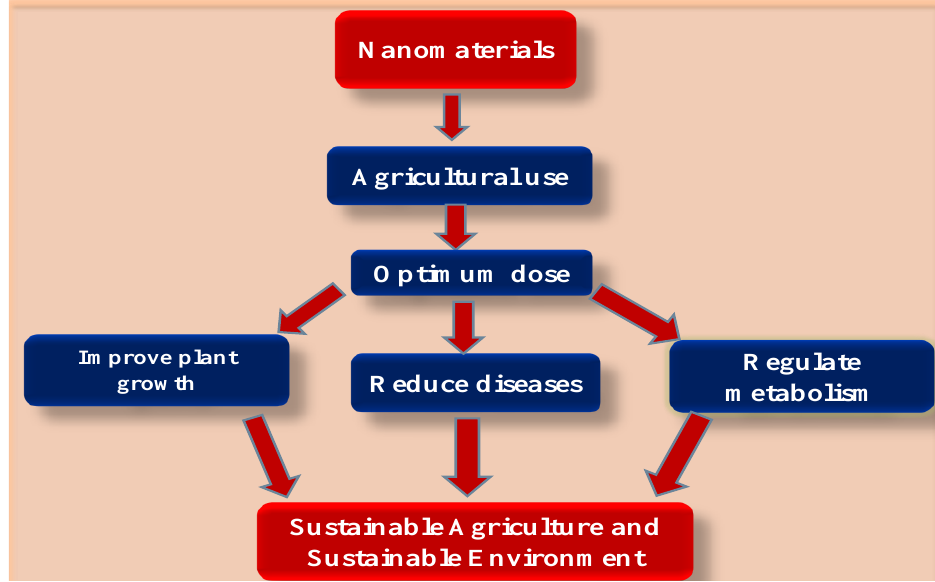
Figure 1. Schematic presentation of nanomaterials in agriculture. [12]